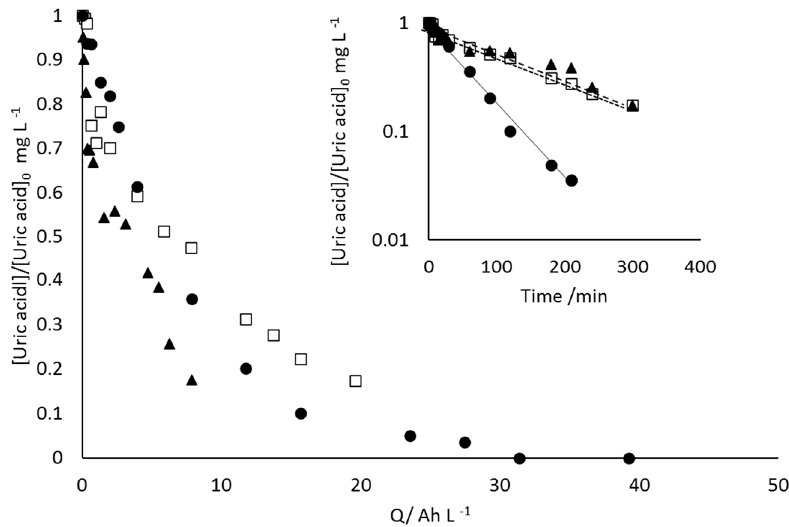
Figure 3. Changes in the concentration of uric acid during the electrolysis of synthetic urine / methanol system with BDD anodes at different current densities and at 6.77 mL·s − 1 of flowrate. Current density: ( (cid:78) ) 20 mA · cm − 2 ; ( (cid:3) ) 50 mA · cm − 2 ; ( • ) 100 mA · cm − 2